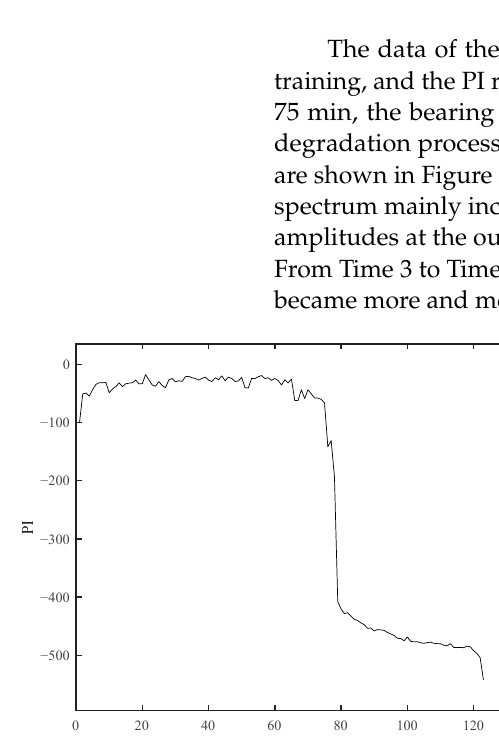
Table 7. RMI of Bearing 1-1 optimal features.